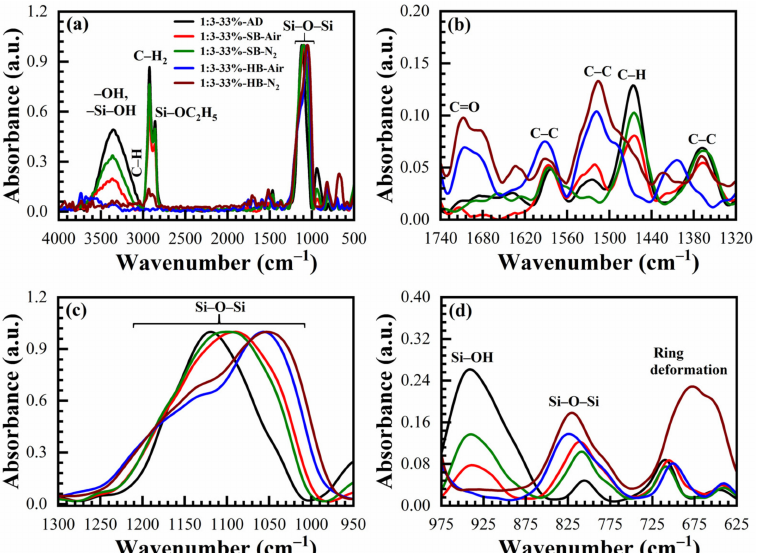
Figure 7. FTIR spectra of benzene-bridged (135TTEB:13BTEB = 1:3 material) organosilicate films with 33 wt% porogen loading, where ( a ) is the full FTIR spectra and ( b – d ) are the parts of the full FTIR spectra. The films are as-deposited (AD), soft baked (SB) at 150 ◦ C in the air (SB-Air) and N 2 (SB-N 2 ) for 30 min, hard baked (HB) at 400 ◦ C in the air for 30 min (HB-Air) and in N 2 for 60 min (HB-N 2 ).